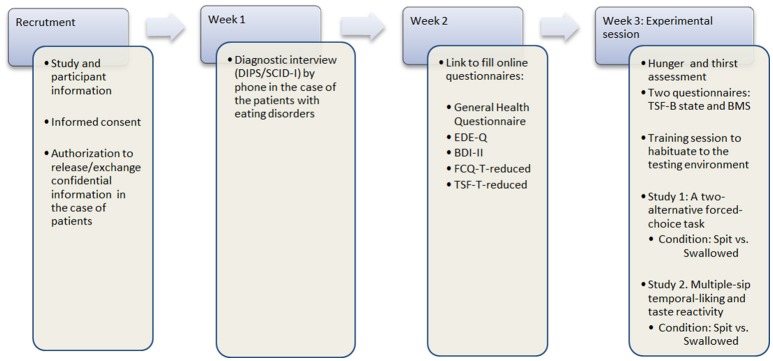
Flow graph of the procedure.